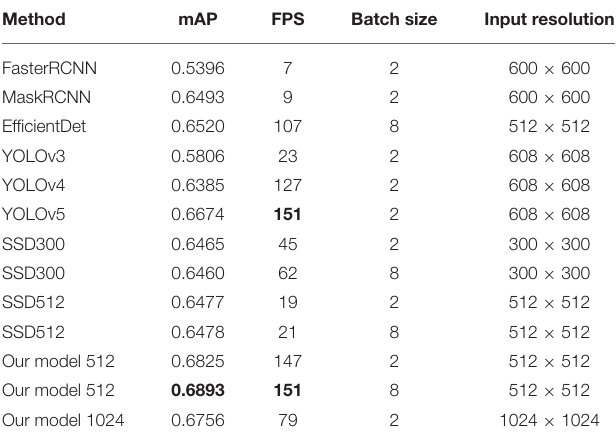
TABLE 1 | Comparison of variant models and our model.